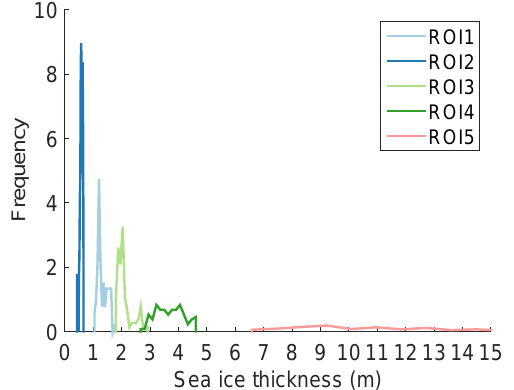
Figure 5. Histograms of sea ice thickness (m) measured during the helicopter flight 3 September 2011 for each of the five regions of interest (ROIs).